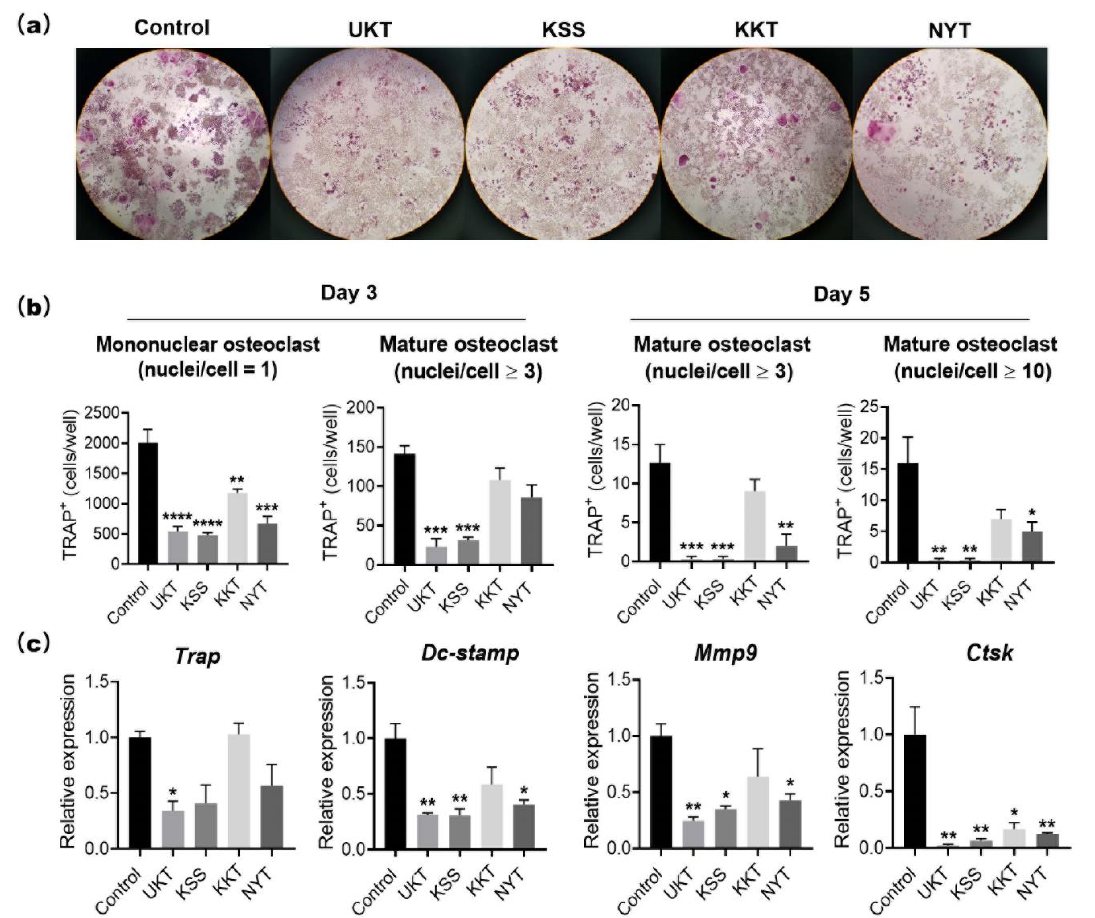
Figure 1. Unkeito (UKT), Kamishoyosan (KSS), Kamikihito (KKT), and Ninjinyoeito (NYT) decrease tartaric acid resistant phosphatase (TRAP)-positive cells at the different stages of osteoclast differentiation. ( a ) TRAP staining for osteoclasts on days 5 (Magnification: ×100); ( b ) number of TRAP-positive mononuclear osteoclasts (nuclei/cell = 1) and mature osteoclasts ( nuclei/cell ≥ 3 or 10 ) on days 3 and 5 ( n = 3); ( c ) the expression levels of osteoclast-related gene markers Trap , Dcstamp , Mmp9 , and Ctsk normalized to that of Gapdh . Error bars represent ± standard error of the mean. * p < 0.05; ** p < 0.01; *** p < 0.005; **** p < 0.0001, versus the control